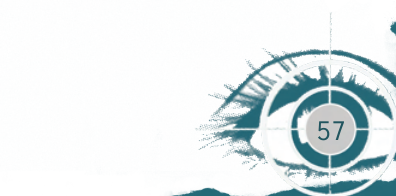
Figure 5 Each small prism with its square aperture ( a) , except the central one, defines a deflected beam of light with the same square cross-section. The beam defined by the central prism is undeflected. Deflection moves the cross-sections away from each other opening up gaps in which there is no light as shown in successive transverse planes ( b) 0.5 m, ( c) 1.0 m and ( d) 1.5 m downstream from the lens. The pattern as a whole retains a square cross-section that turns clockwise and enlarges as one follows the light downstream. In ( c) it has rotated 45 ° clockwise relative to the lens. The individual squares of light that make up the pattern are themselves not twisted. The blue square moves to the right; the orange square moves down- ward; and green square moves right and